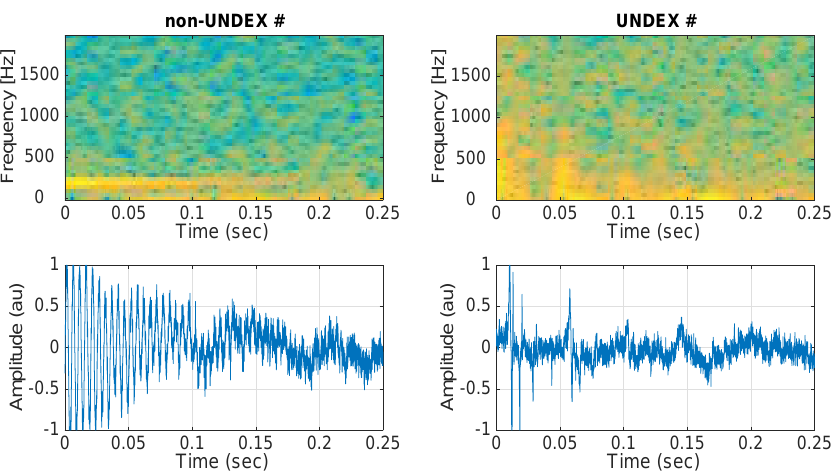
Figure 4. Example of simulated non-UNDEX and UNDEX events (although they are very different, distinguishing between them may be challenging when they are severely